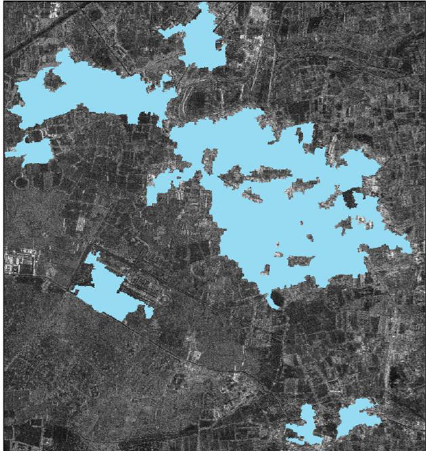
Figure 27. Feature Extraction form the amplitude Image.